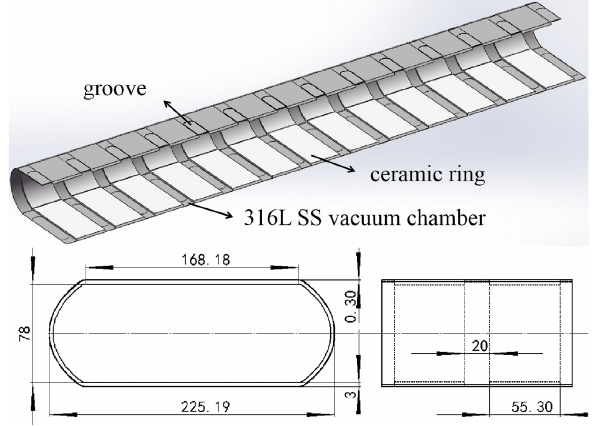
FIG. 2. Ceramic rings-loaded thin-wall 316L SS vacuum